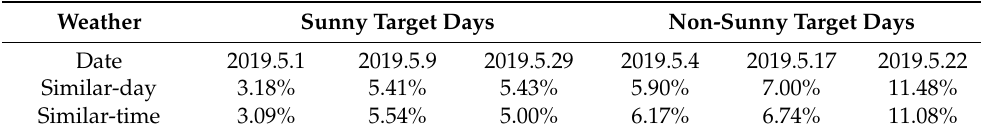
Table 3. Prediction error rate using 1DCNN-LSTM on target